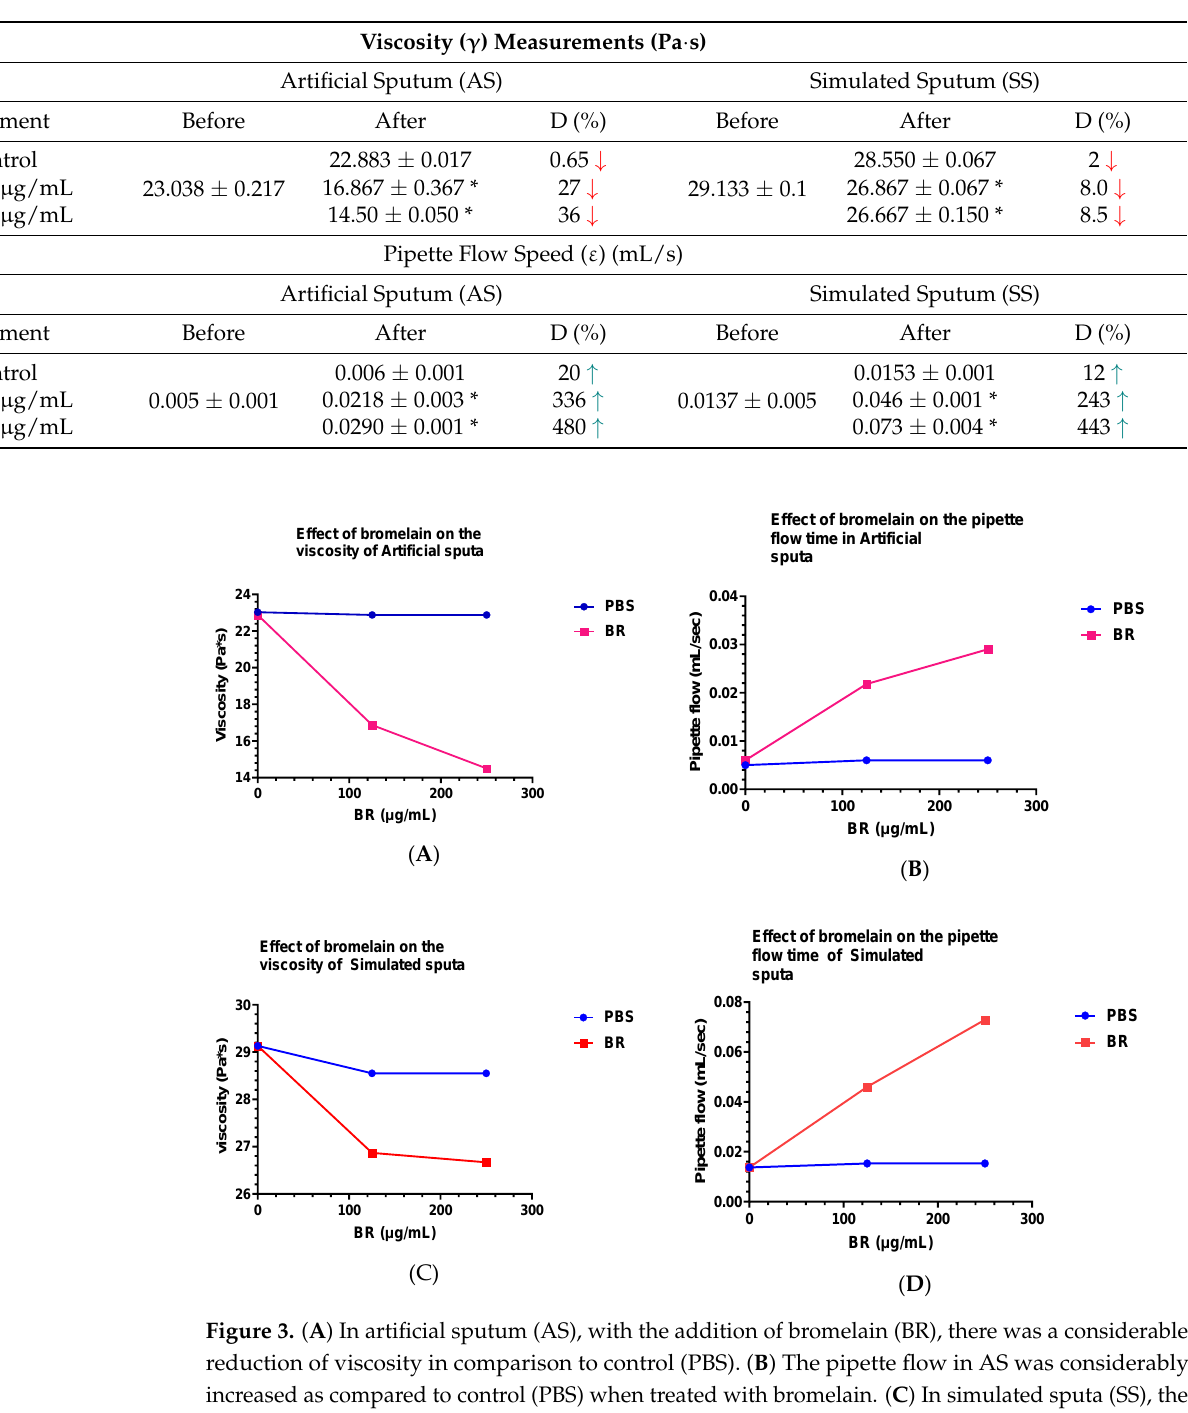
Table 3. The effect of aerosolized bromelain (BR) on both artificial (AS) and simulated sputa (SS) using two parametric measurements, viscosity ( γ ) and pipette flow time ( ε ). Data presented as mean ± SD. Test samples were compared with control after treatment for significance testing; *: p < 0.05; ↓ = decrease; ↑ = increase.